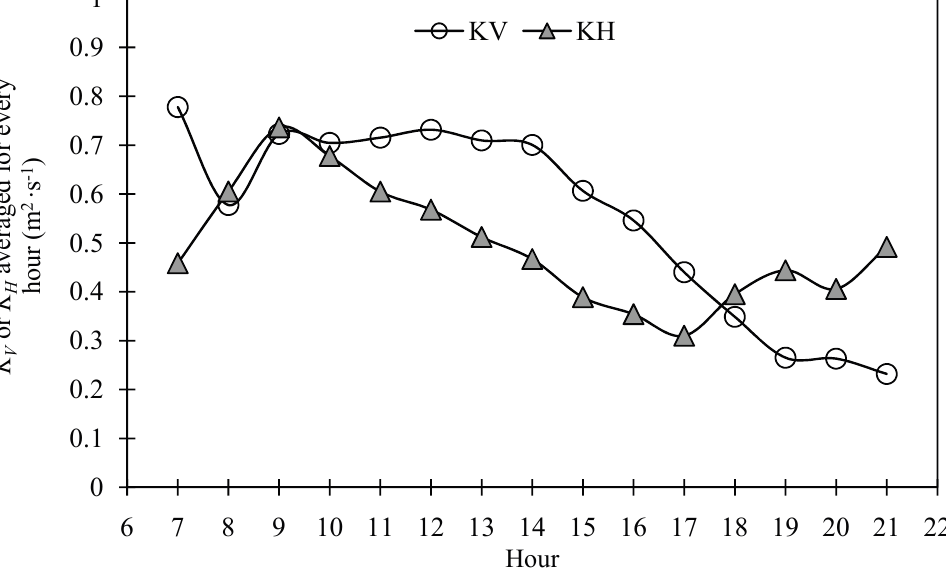
Figure 5. Diurnal variations of K and K for every hour from 07:00 to 21:00 during the 2005 and 2006 growing and K V H non-growing (dormant)